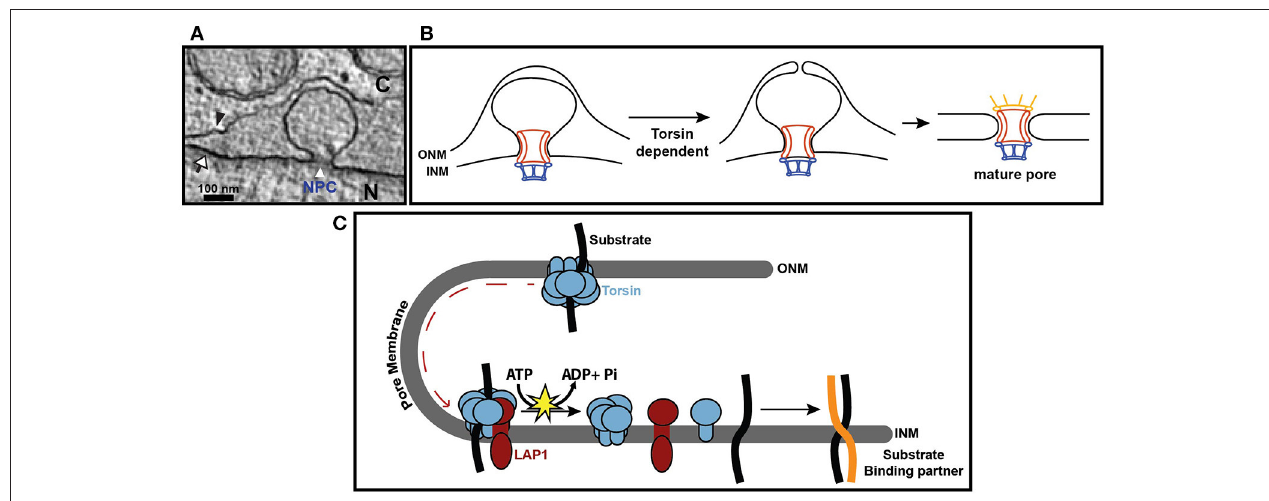
FIGURE 2 | Torsin function at the nuclear envelope. (A) EM cross section of nuclear envelope blebbing observed in Torsin-deficient HeLa cells. N, nucleus; C, cytoplasm; black arrowhead, ONM; white arrow, INM; white arrowhead, electron density at the base of the blebs containing nucleoporins. (B) Model depicting how blebs could arise from stalled NPC assembly. In this model, Torsin would function at a step prior to or at membrane fusion. (C) Hypothetical model for Torsins as a trafficking chaperones that deliver proteins to the inner nuclear membrane. INM-resident proteins are sequestered by Torsins during de novo synthesis in the ER or the contiguous ONM, preventing their premature assembly into protein-protein complexes that would compromise or prevent their trafficking through the pore membrane. Upon arrival at the INM, the high local concentration of LAP1 would trigger ATP hydrolysis in Torsins, leading to the disassembly of the Torsin ring and substrate release. Released substrates can then engage in protein-protein complex formation at the